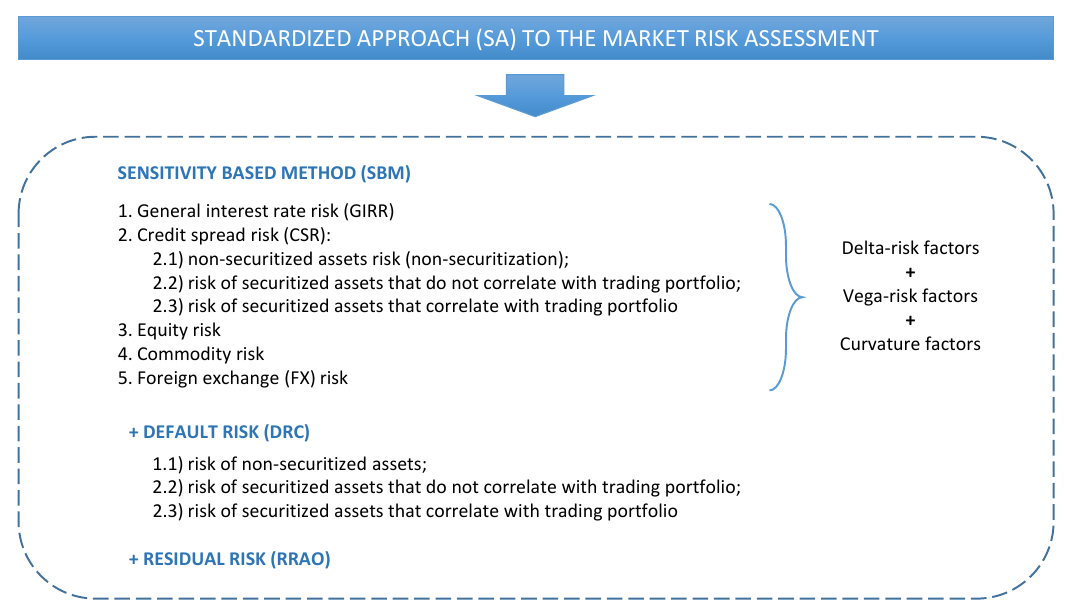
Figure 1. General structure of capital requirements according to the standardized approach